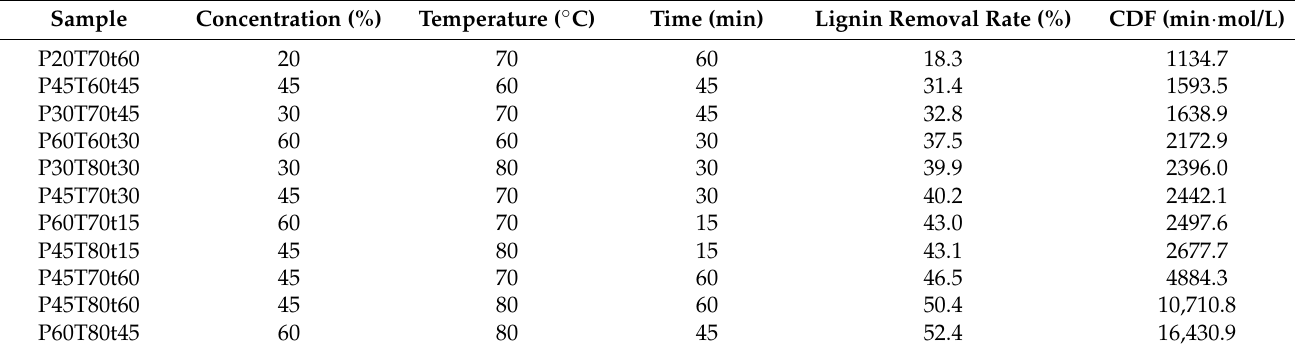
Table 1. Rice straw lignin removal rate under a range of p -TsOH fraction